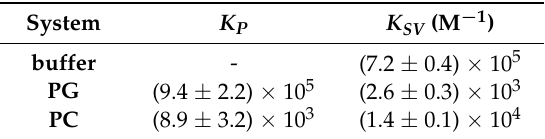
Table 2. Partition coefficient, K P , values obtained from the fit of Equation (1) and Stern Volmer constants, K SV , determined from Equation (2) for HTMA-PFBT in buffer and in anionic and zwitterionic